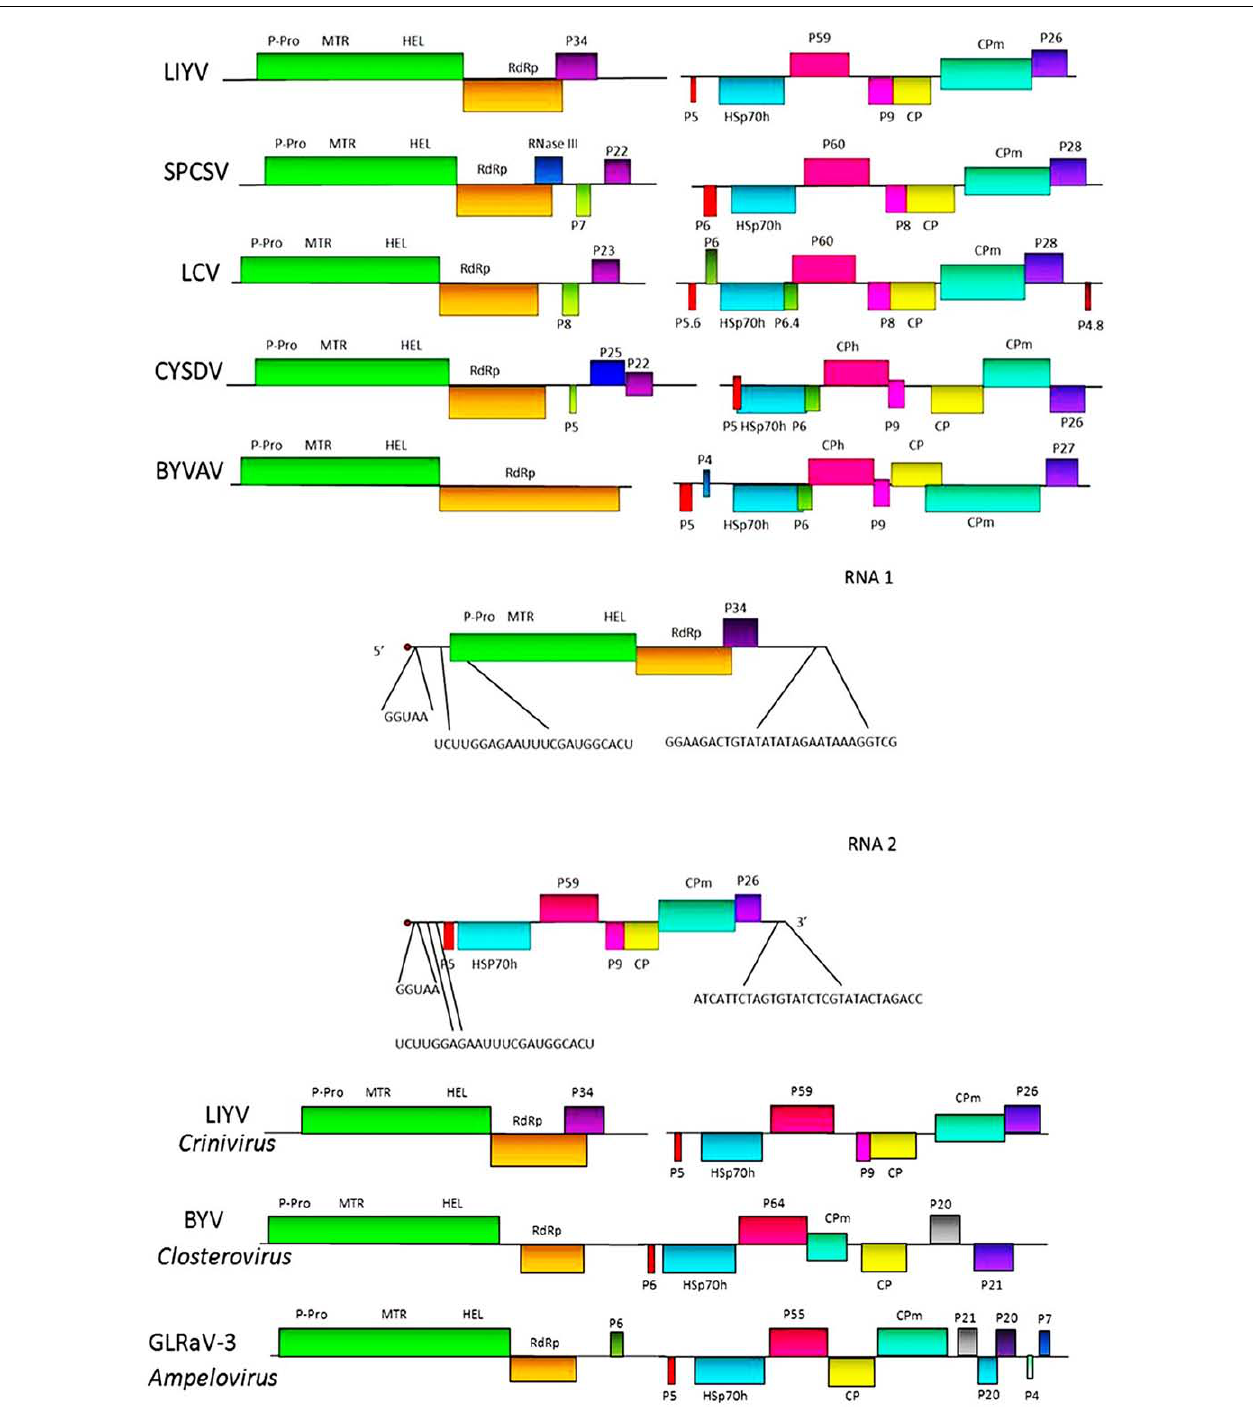
FIGURE 2 | Upper section shows genome maps for the bipartite genomic RNAs for five criniviruses. LIYV = Lettuce infectious yellows virus ; SPCSV = Sweet potato chlorotic stunt virus ; LCV = Lettuce chlorosis virus ; CYSDV = Cucurbit yellow stunting disorder virus , and BYVAV = Blackberry yellow vein associated virus . Colored boxes indicate specific ORFs. P-Pro – papain-like protease; MTR = methyl-transferase; HEL = helicase; RdRp = RNA-dependent RNA polymerase; HSp70h = heat shock protein 70